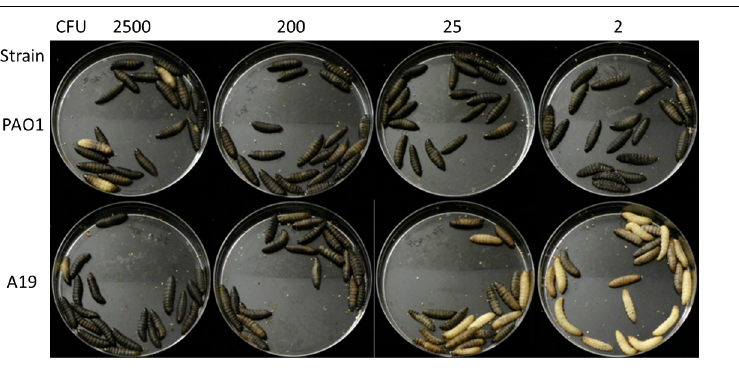
Fig 8. Survival of Galleria melonella larvae after injection with P . aeruginosa PAO1 or A19. Fifth-instar G . mellonella larvae were injectedin the left hind prolegwith different amounts of P . aeruginosa PAO1 and A19 bacteria. The image was captured 18 hours post infection. Healthy larvae are cream colored, and darker pigmentation indicatesinfection. Dead larvae can be recognized from their dark brown-blackcolor.